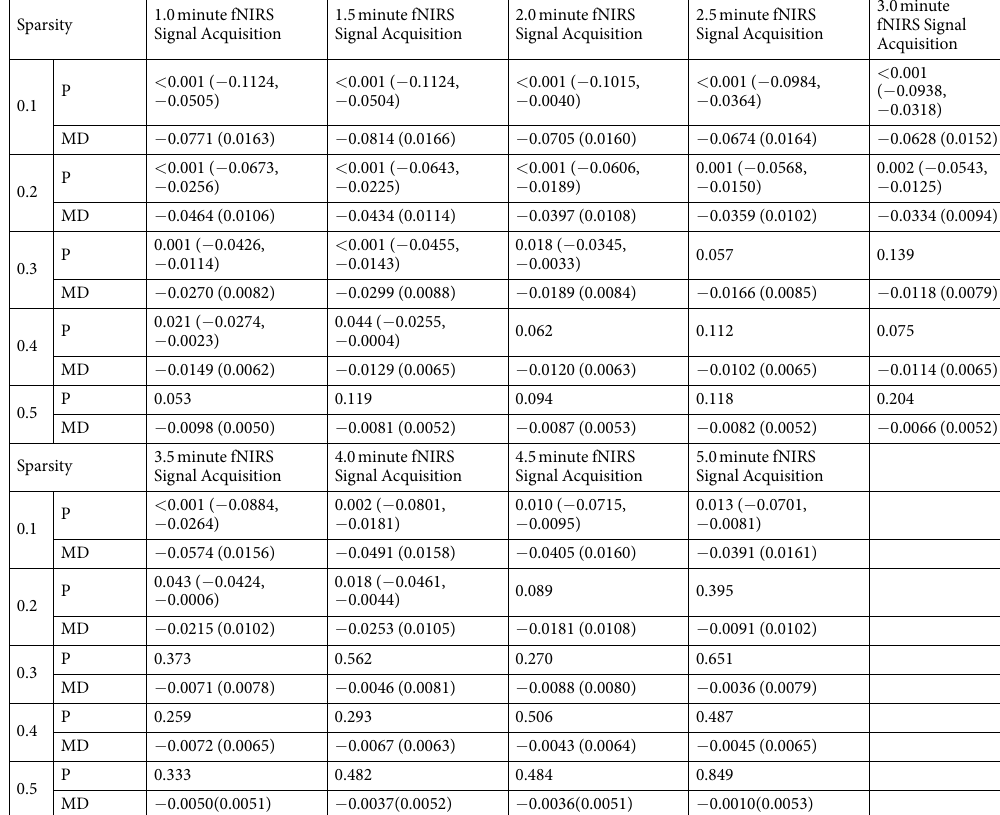
Table 2. Dunnett Post Hoc Analysis Data for Local Efficiency Stability Associated with fNIRS Signal Acquisition Duration. Note—Dunnett post hoc analysis data using the longest fNIRS signal acquisition duration (10.0 min) as the control group for pairwise comparisons. Data are P values (data in parentheses are 95% CIs) and Mean Difference (STD